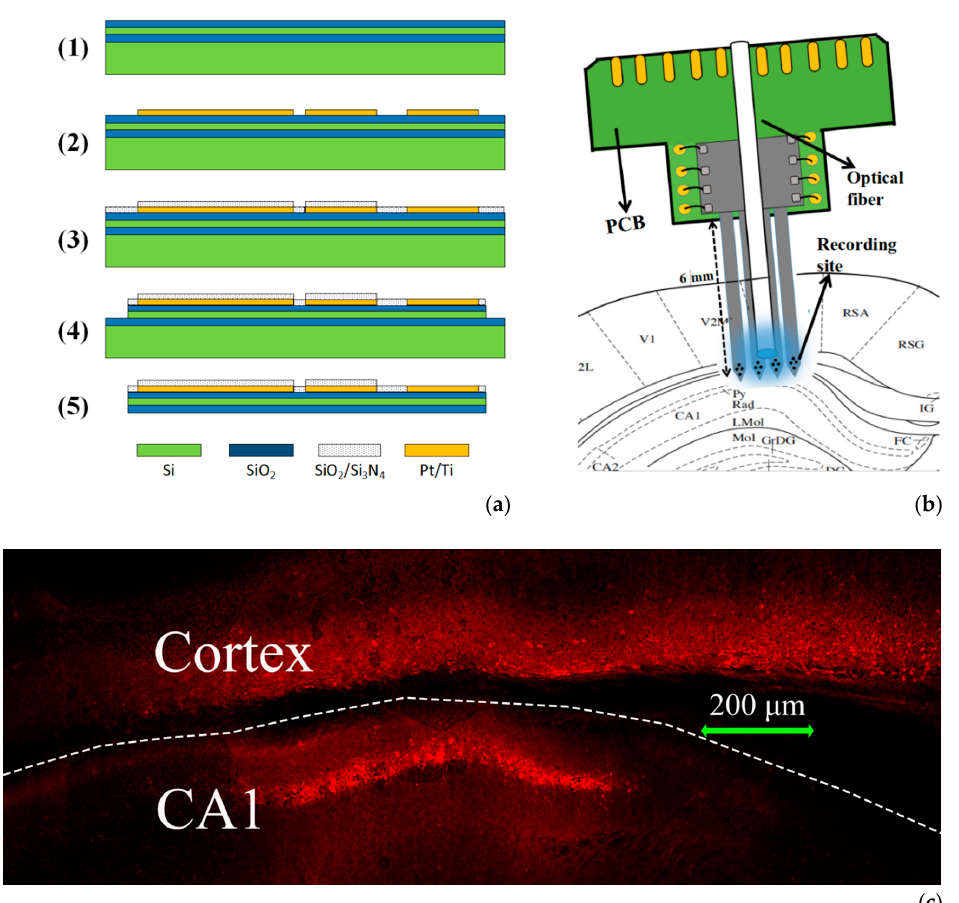
Figure 1. ( a ) Microelectrode array (MEA) manufacturing process: (1) Deposition of a layer of SiO 2 on silicon-on-insulator (SOI). (2) Photolithography, sputtering and lift-off to form conductive layer. (3) Deposition of the insulating layer and exposure of recording sites and bonding pads. (4) Formation of the shape of the MEA. (5) Release of the MEA from the substrate. ( b ) Schematic diagram of the integrated device inserted into hippocampal CA1 of brain. ( c ) The fluorescence image of brain area infected by rAAV .